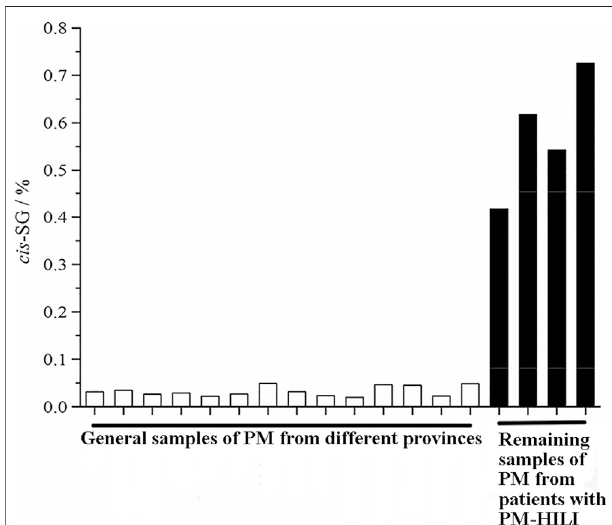
FIGURE 2 | The content of cis -SG in the remaining samples of PM from patientswith PM-HILI issigni fi cantly higher than that ofthe generalsamplesof PM from different provinces. Adapted with permission from reference (Zhang et al., 2017a). Abbreviations: cis -SG, cis -2,3,5,4 ’ -tetrahydroxystilbene- 2-O- β -glucoside; PM, Reynoutria multi fl ora (Thunb.) Moldenke; PM-HILI, PM- related herb-induced liver